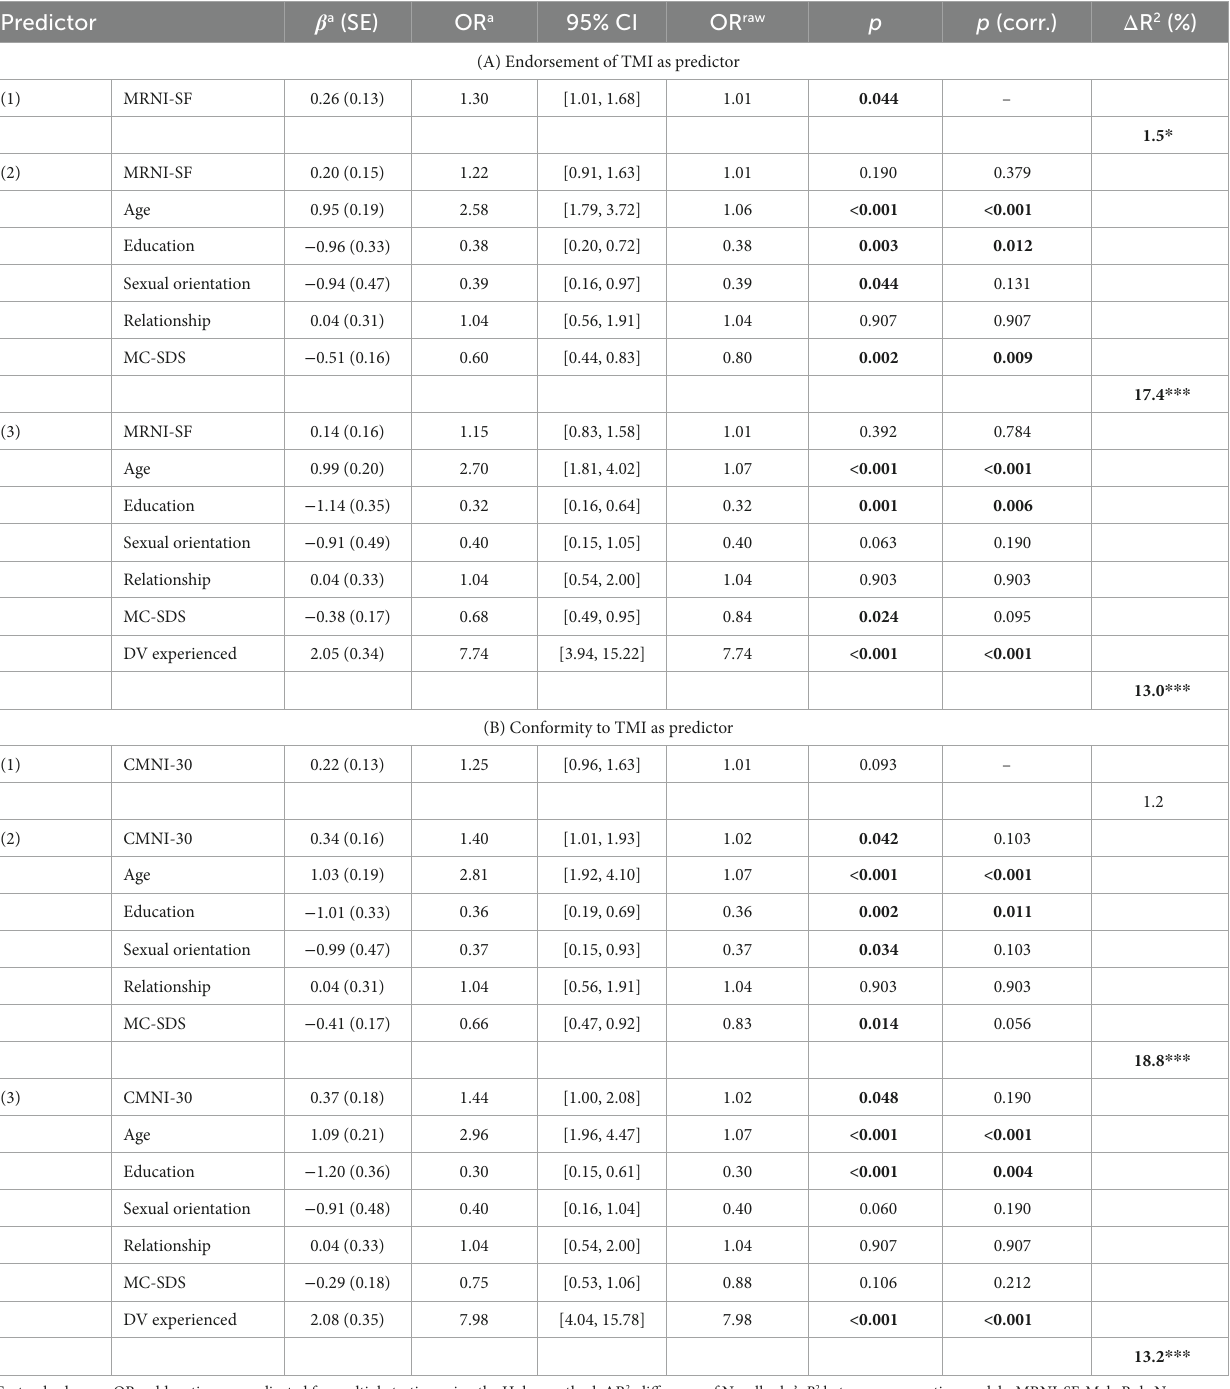
TABLE 4 Binomial logistic regression models with DV perpetration as outcome variable.